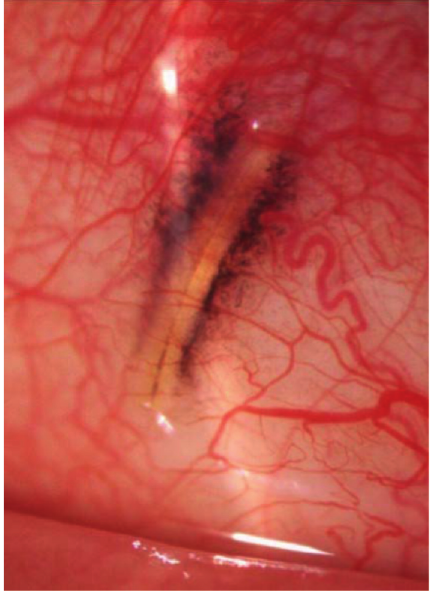
Figure 3: Complications of XEN implantation—protrusion under the conjunctiva.